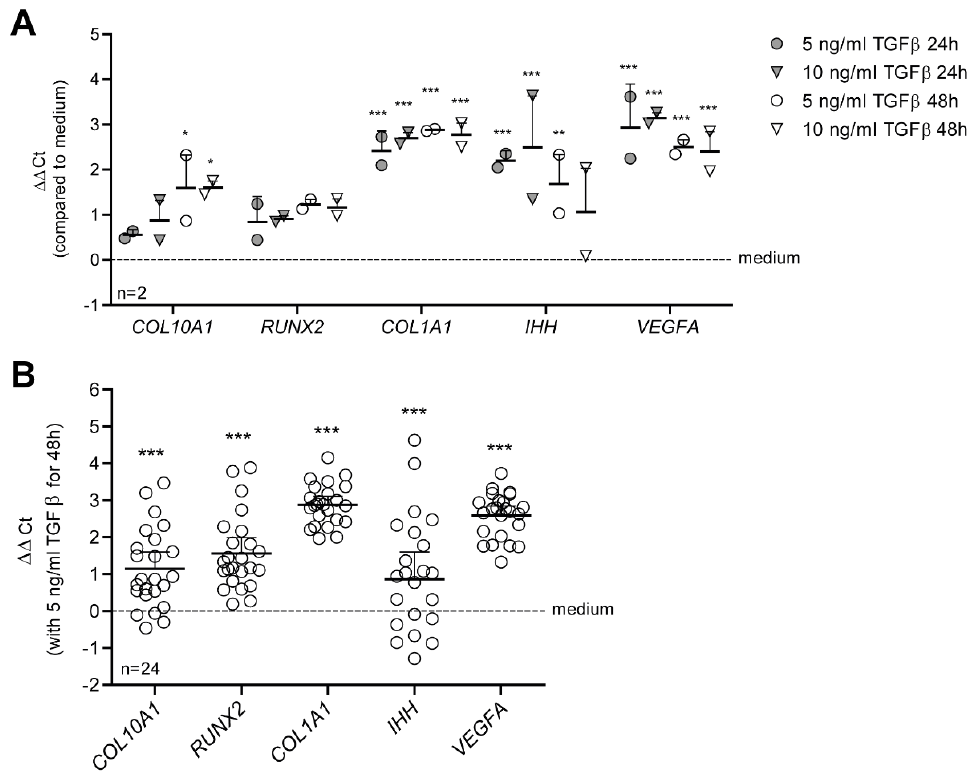
Figure 1. TGF- β 1 drives a hypertrophy-like phenotype in primary human OA chondrocytes. Elevated levels of TGF- β that are comparable to those in synovial fluid of OA patients increase expression of crucial hypertrophy genes. ( A ) Human chondrocytes of two donors were cultured in monolayer and stimulated with 5 or 10 ng/mL TGF- β 1 for 24 or 48 h. This resulted in induction of hypertrophy-like differentiation, as measured by increased expression of relative collagen type 10 ( COL10A1 ), runt- related transcription factor 2 ( RUNX2 ), alpha-1 collagen type 1 ( COL1A1 ), Indian hedgehog ( IHH ) and vascular endothelial growth factor A ( VEGFA ) using qPCR. ( B ) These results were verified in chondrocytes of another 24 donors, stimulated for 48 h with 5 ng/mL TGF- β 1. Data are plotted as mean ± 95% CI with each dot representing the average of three technical replicates in one chondrocyte donor. Statistical analysis was performed using a repeated measures two-way ( A ) or one-way ( B ) ANOVA with Bonferroni’s post hoc test: * p ≤ 0.05; ** p ≤ 0.01; *** p <